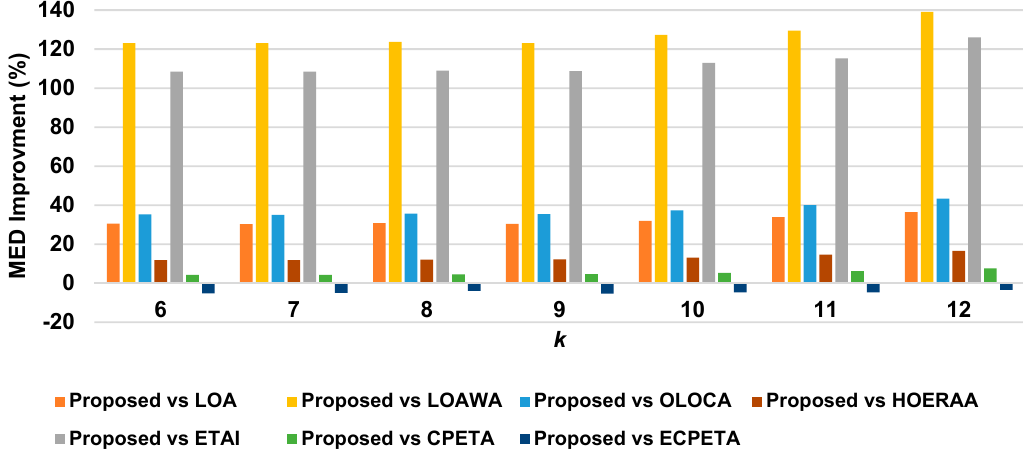
Figure 7. Improvements in the mean error distance (MED) of the proposed HERLOA in comparison with those of seven approximate adders at various values of k.